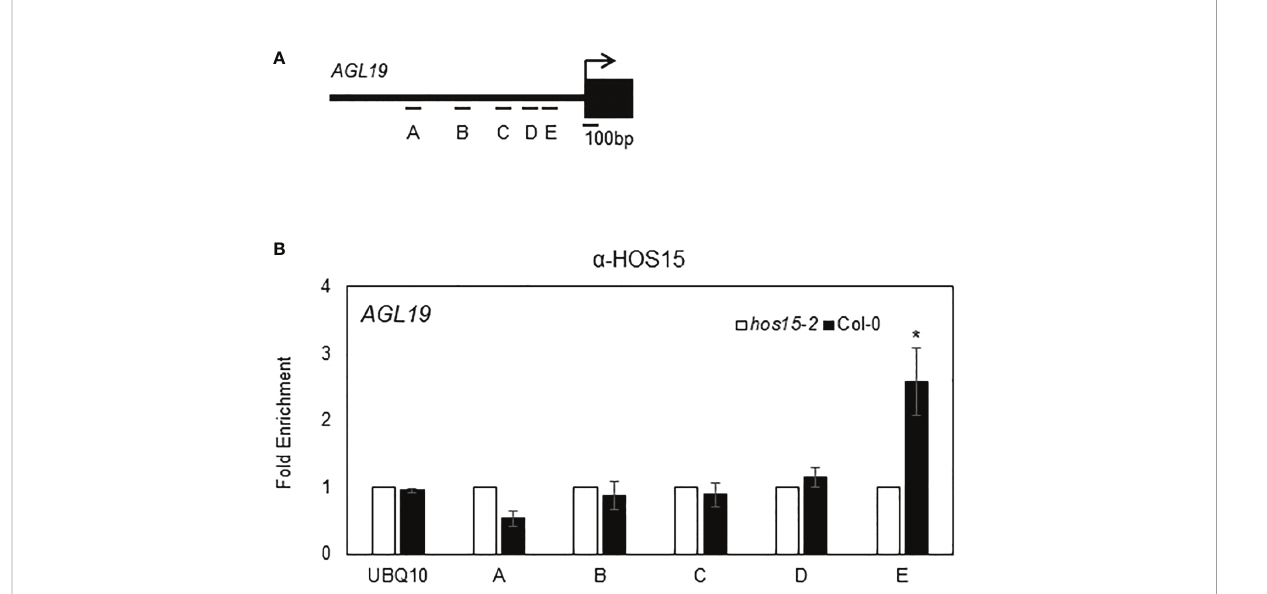
FIGURE 2 Association of HOS15 with the AGL19 promoter region. (A) Amplicon regions (A – E) in the AGL19 promoter used for ChIP-qPCR. The arrow indicates the transcriptional start site. (B) The ChIP assays were performed using the anti-HOS15 antibody on samples from two-week-old wild- type (Col-0) and hos15-2 mutant plants. The amount of DNA in the immunoprecipitated complex was determined by RT-qPCR using primers speci fi c to the different regions (A – E) of the AGL19 promoter and is presented as the fold enrichment after normalization with the corresponding input and compared with hos15-2 mutant plants. Data represent means ± SD from three biological replicates with three technical repeats each (n = 3). Signi fi cant difference was determined by a Student ’ s t-test (*